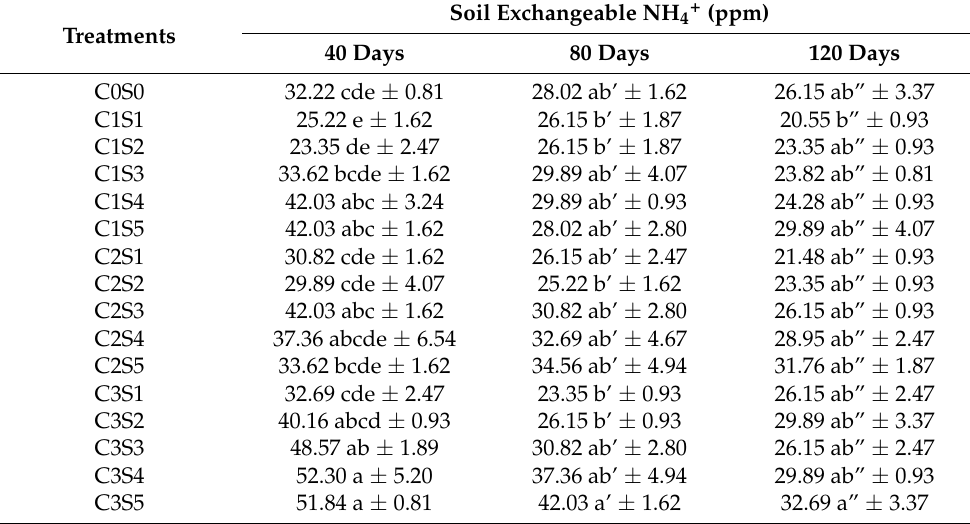
Table 8. Mean soil exchangeable ammonium in relation to combined use of Calciprill and sodium silicate at forty, eighty, and one hundred and twenty days incubation. Treatments